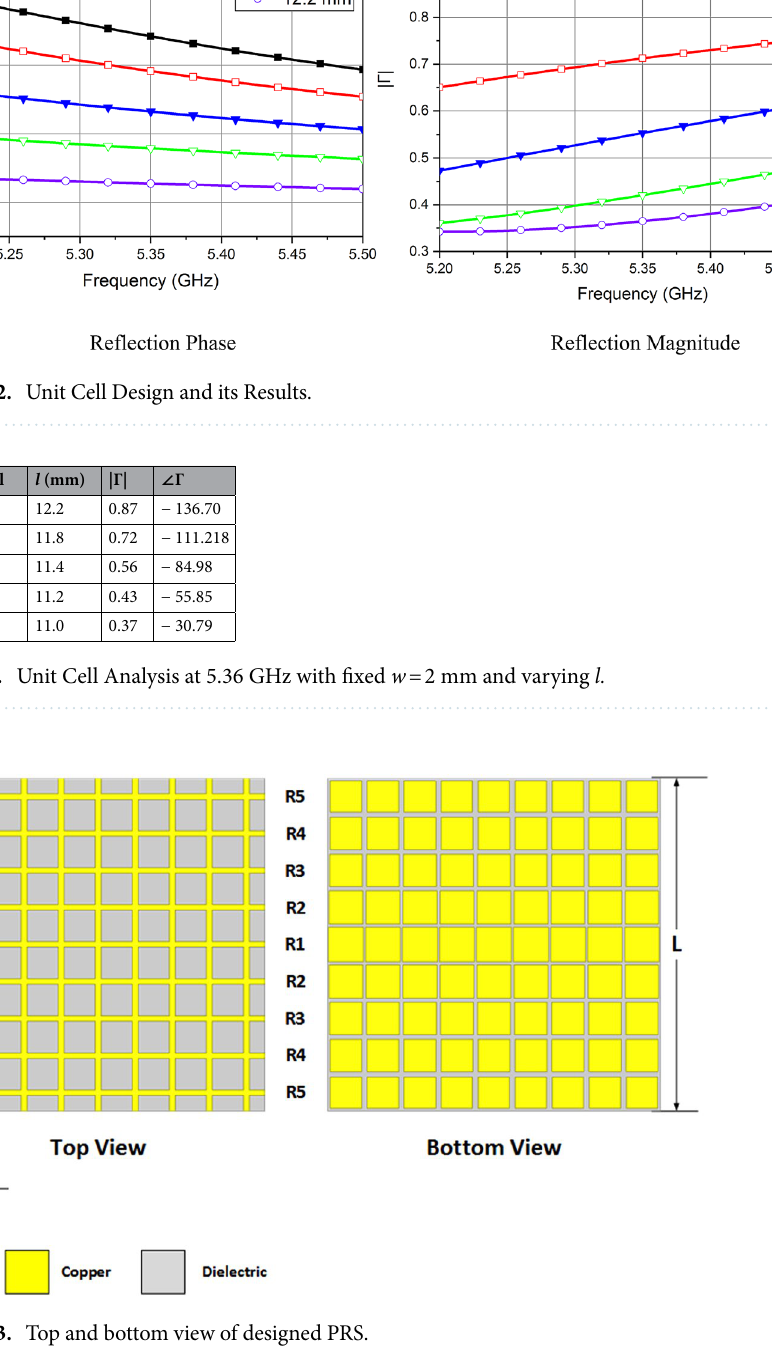
Figure 3. Top and bottom view of designed